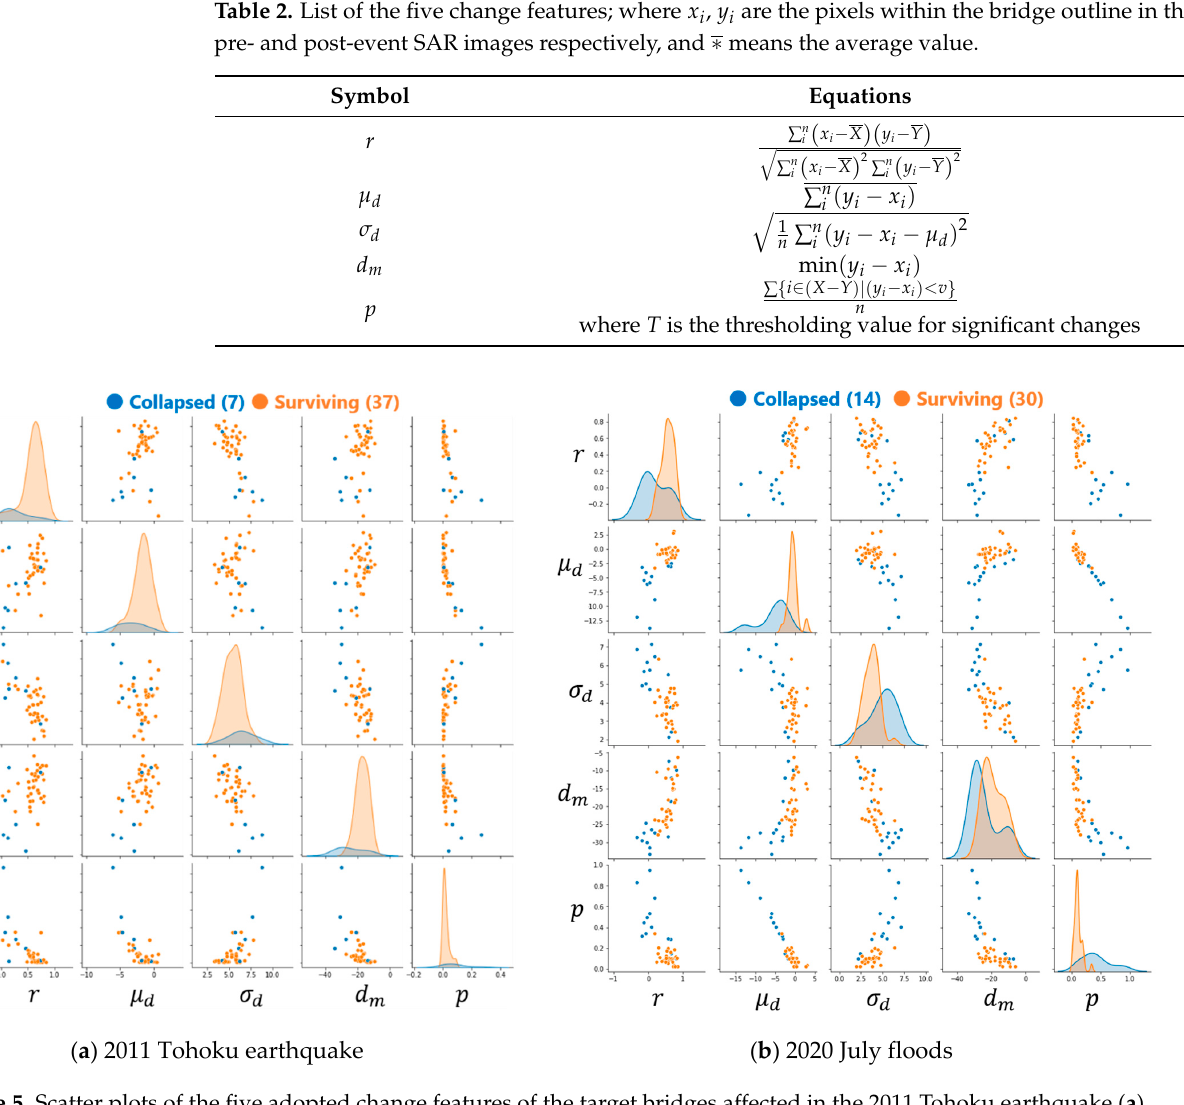
Table 2. List of the five change features; where 𝑥 (cid:3036) , 𝑦 (cid:3036) are the pixels within the bridge outline in the pre- and post-event SAR images respectively, and ∗(cid:3364) means the average value.